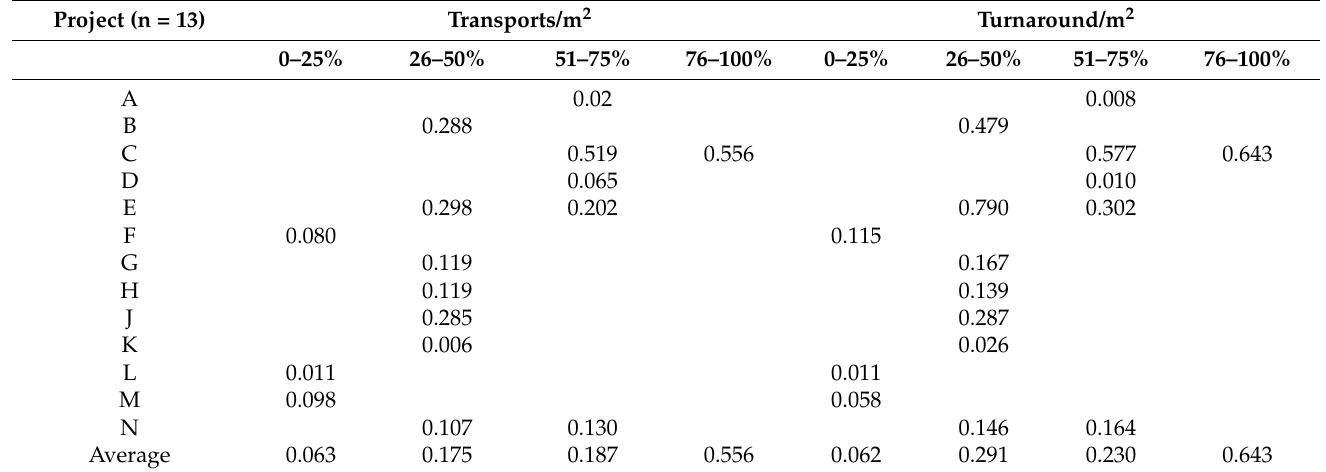
Table 6. Transports and turnaround per m 2 for the different completion percentages of the 13 projects.